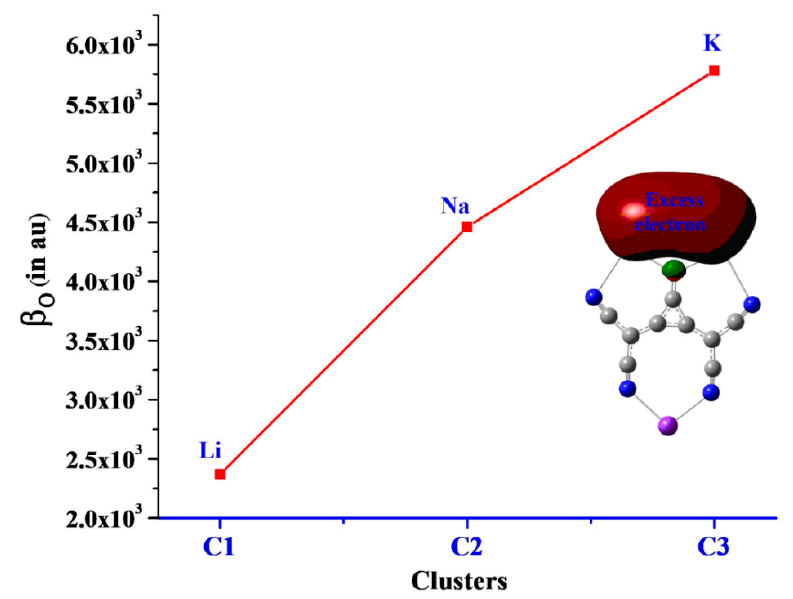
Figure 5. The representation of size-dependent hyperpolarizability ( β o ).